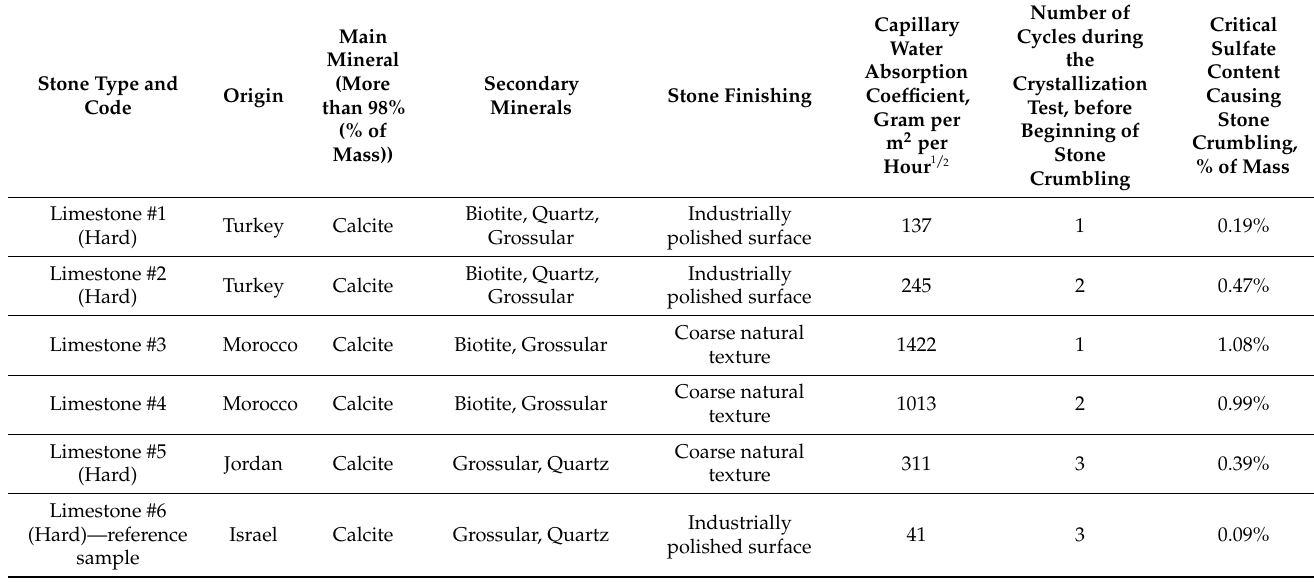
Table 3. Properties of limestones used in high-rise buildings in coastal zone in Israel.